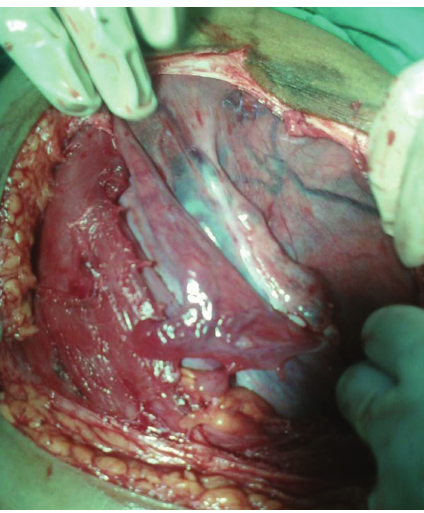
Figure 1: Posterior wall uterus with left adnexa turned to right.